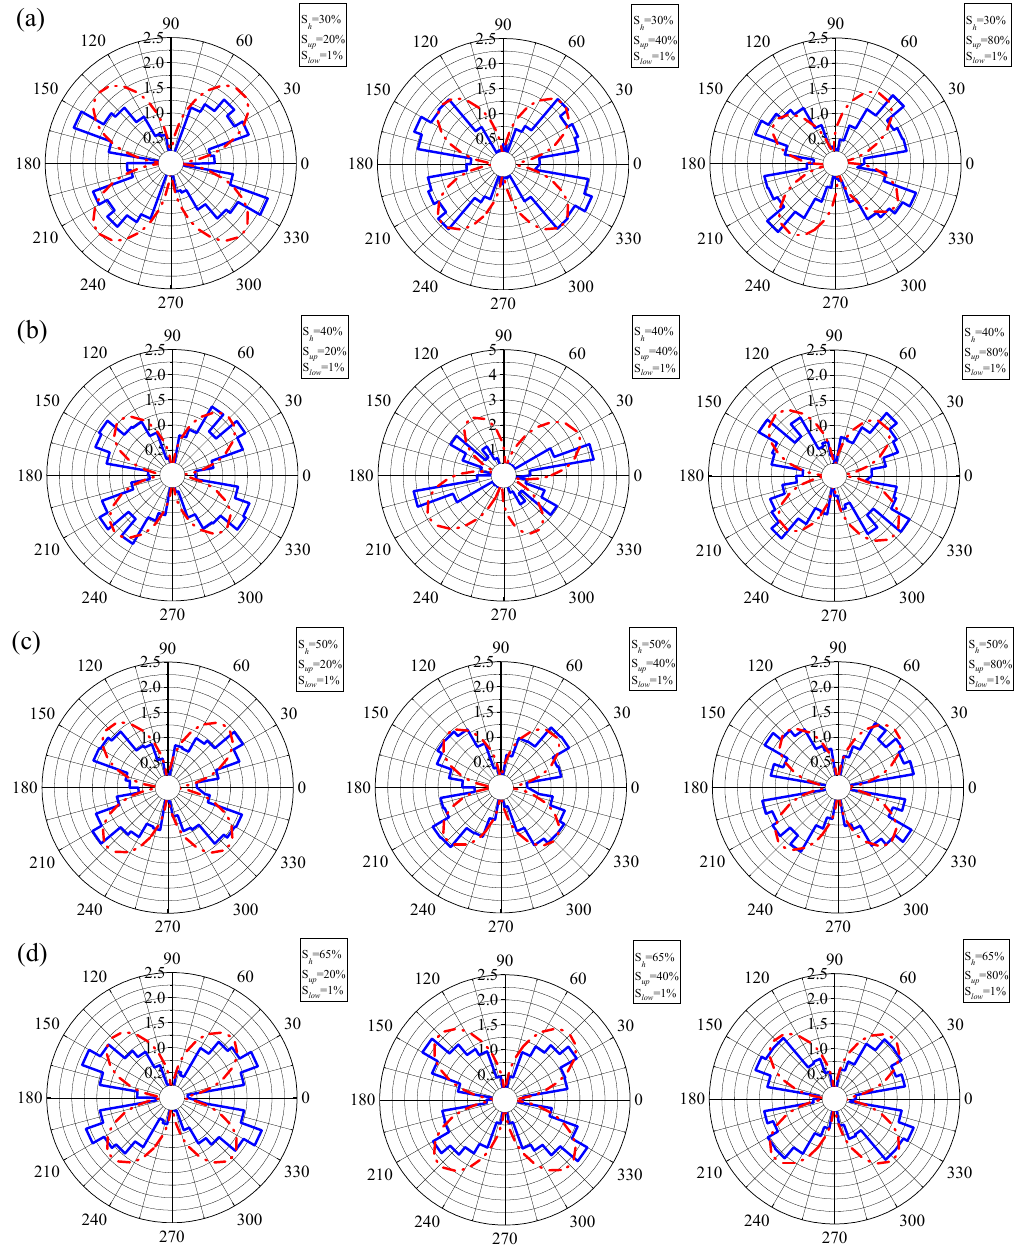
Figure 14. The evolution of the normal contact force between the particles under different dynamic amplitude conditions for MHS with different S h values. (a) S h = 30%; (b) S h = 40%; (c) S h = 50%; (d) S h = 65%.